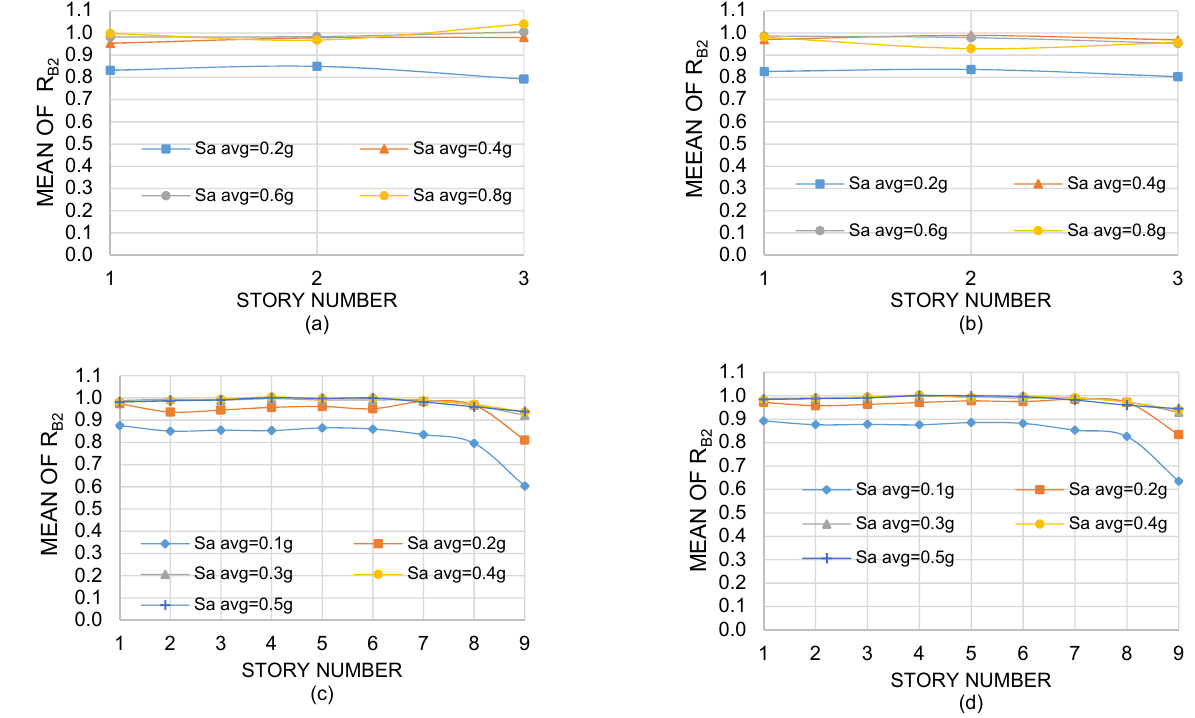
Figure 15. Mean values of R B 2 beams, NS : ( a , b ) exterior and interior, respectively, Model 1; ( c , d ) exterior and interior, respectively, Model 2.